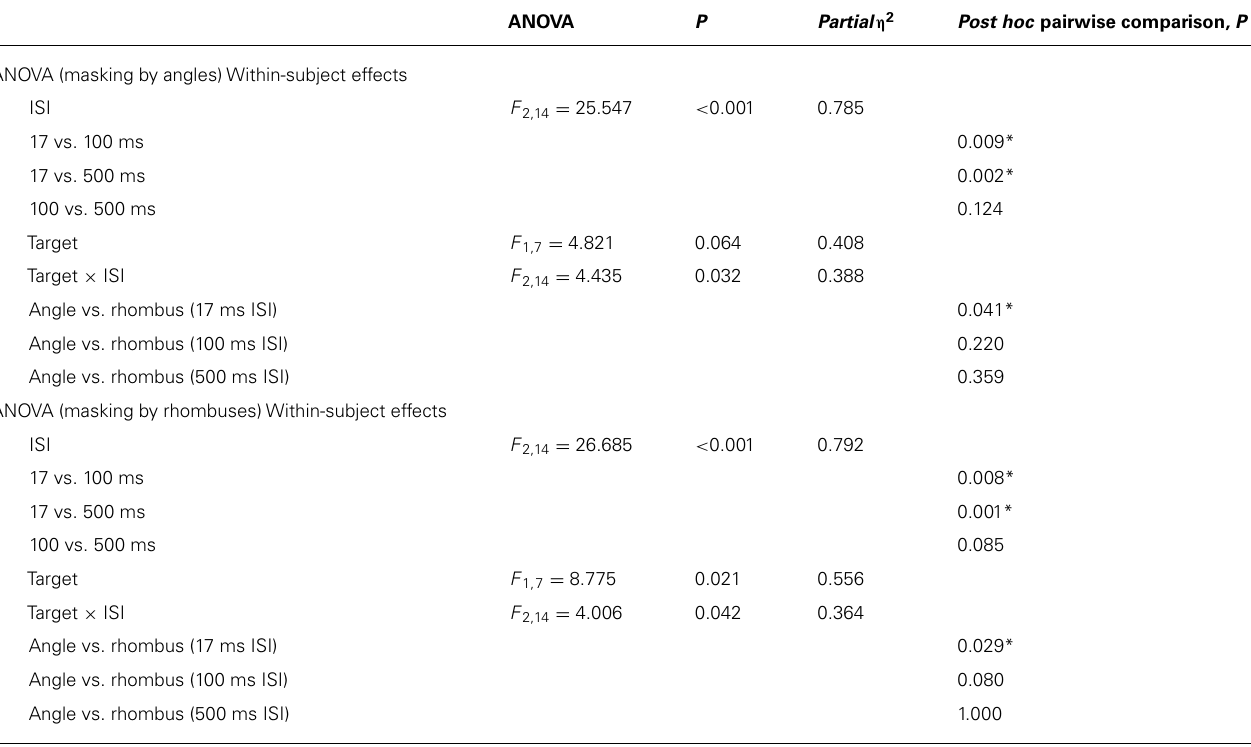
Table 1 | Repeated MeasuresANOVA and post hoc pairwise comparisons for Experiment 1 ( n = 8